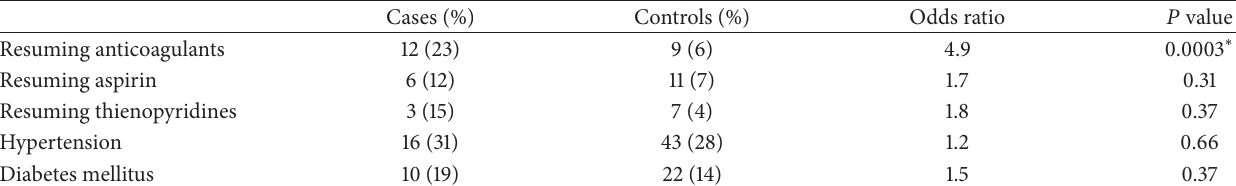
Table 2: Univariate analysis of patient-factors for delayed bleeding.